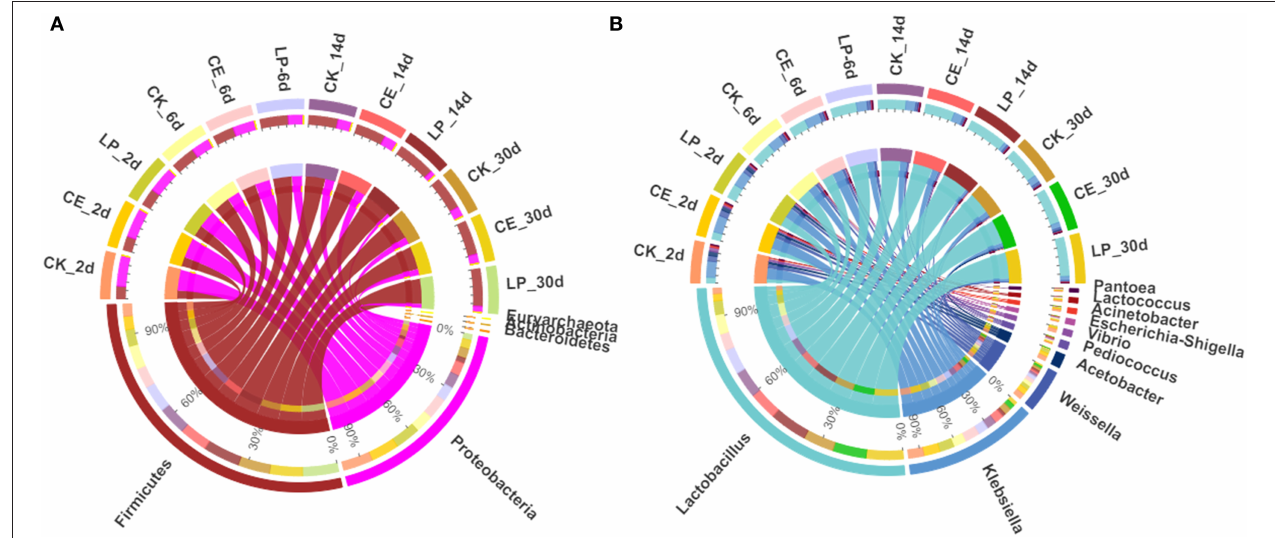
FIGURE 2 | Circos map of bacterial communities at the phylum (A) and genus (B) levels for cassia alata silage (CK, control; CE, cellulase; LP, Lactiplantibacillus plantarum , after 2, 6, 14, and 30 days of ensiling, respectively).